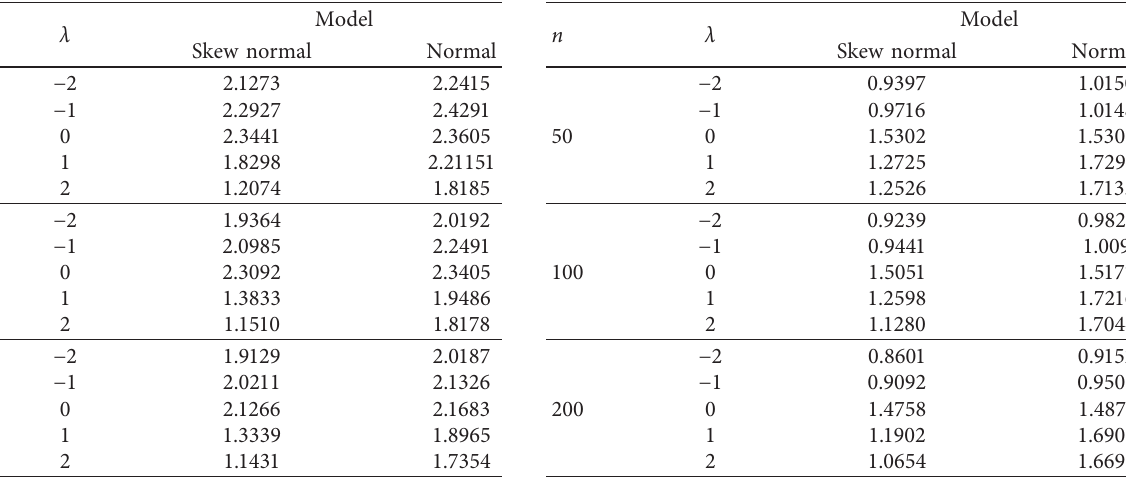
Figure 2: (a) Exact and estimated values of f ( z Model II, h n � 0 . 04 , n � 100. Table 3: RMSE for different values of λ under the normal and SN ( x ) . innovations, f 1